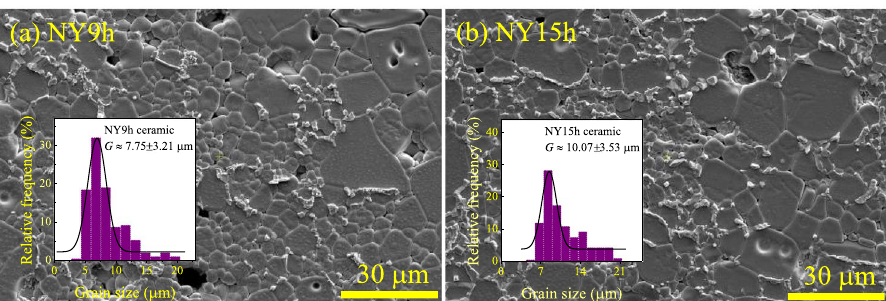
Figure 2. Polished cross-sectional SEM images and size distributions of ( a ) NY9h and ( b ) NY15h